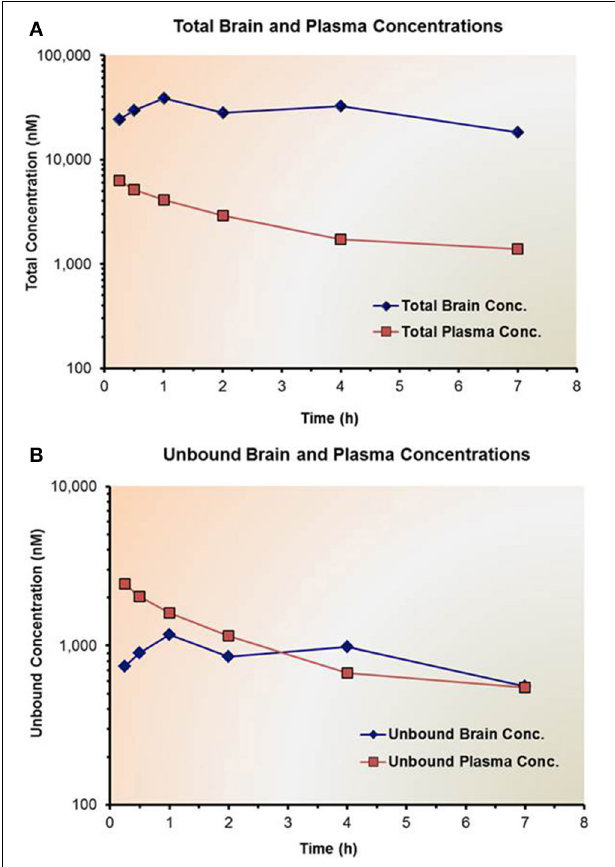
FIGURE 4 | Impact of non-specific binding on the total and unbound concentrations of a drug candidate in plasma and brain. (A) Shows the total drug concentrations in brain and plasma, while (B) shows the corresponding unbound drug concentrations. Both plasma protein and brain homogenate binding studies were conducted using the Rapid Equilibrium Dialysis (RED) device.